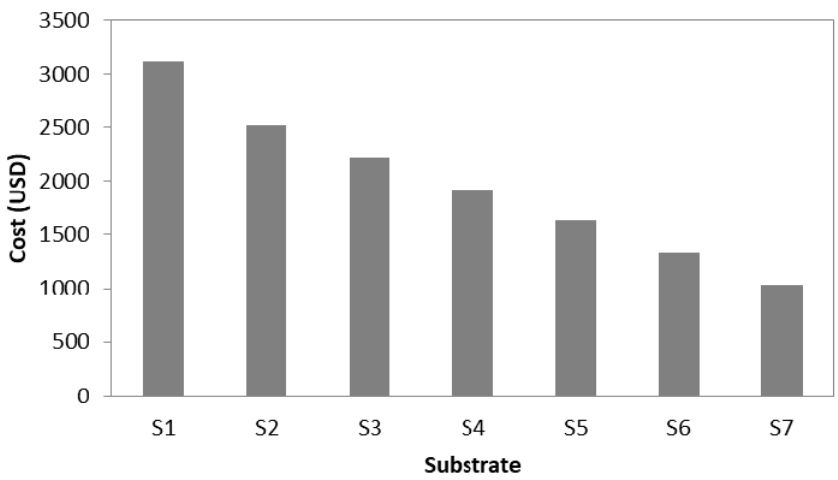
Figure 6. Projected substrate cost in a production of 100,000 seedlings of Pinus engelmannii , produced in polystyrene containers with 77 cavities of 170 mL.